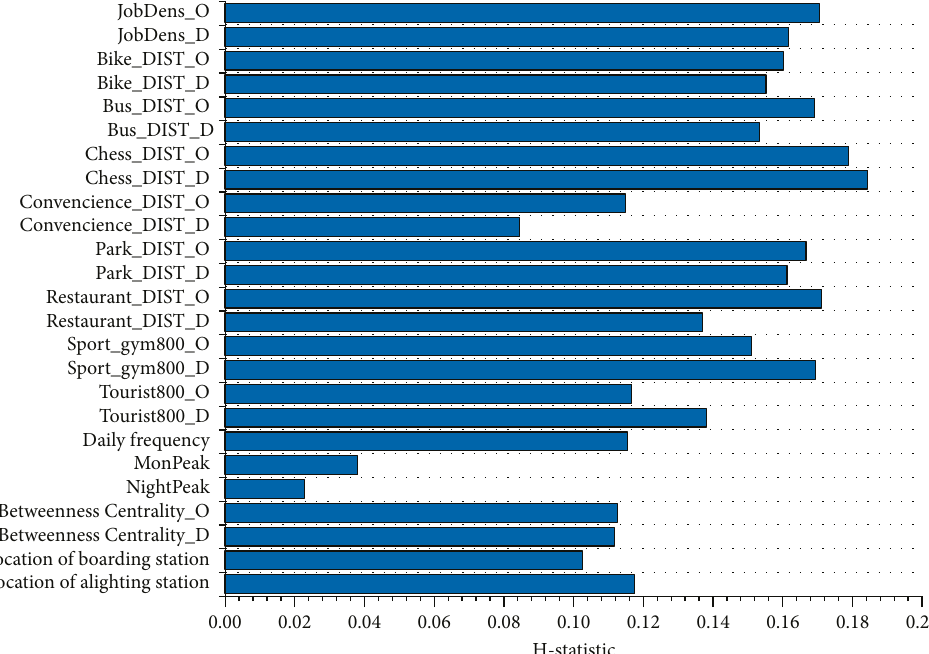
Figure 7: The average interaction strength (H-statistic) for each explanatory variable with other explanatory variables for the GBRTmodel predicting the elderly trip time.